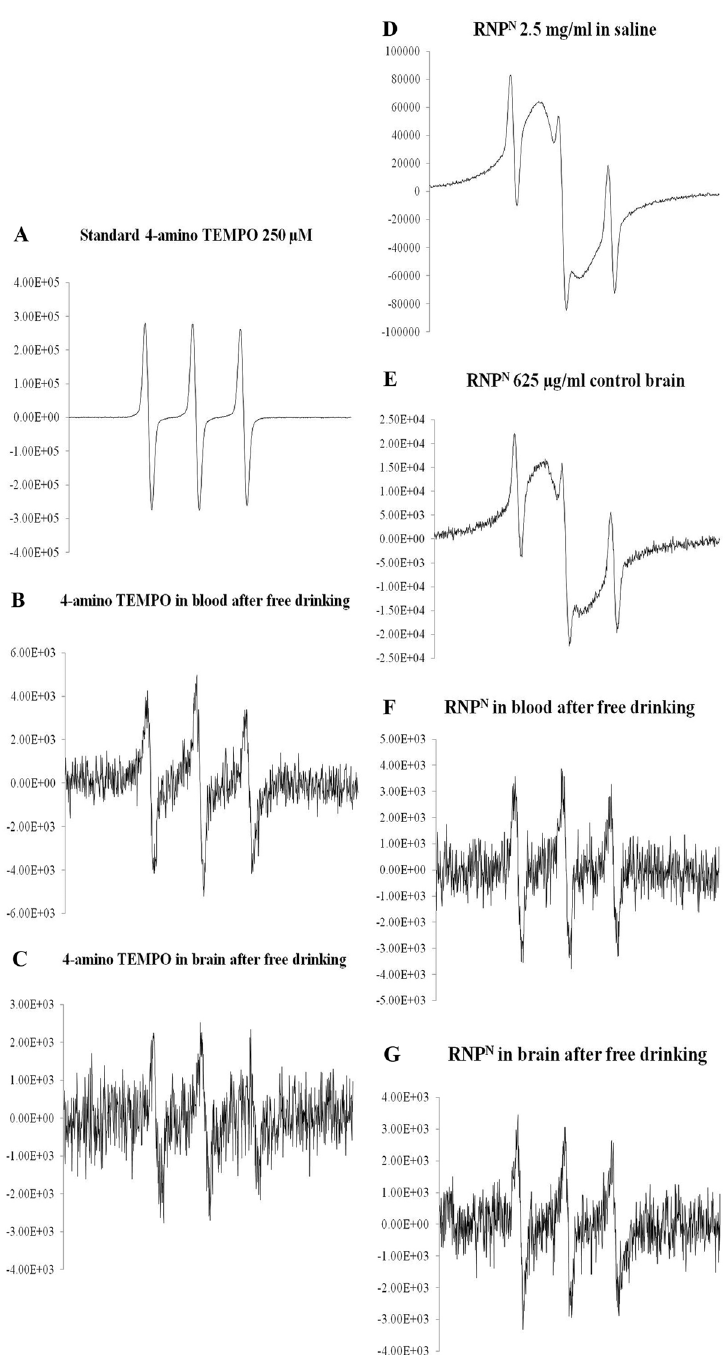
Figure 1. The electron spin resonance (ESR) spectra of 4-amino-TEMPO standard in saline ( A ), 4-amino- TEMPO in the blood after ad libitum drinking for 6 months ( B ) 4-amino-TEMPO in the brain after ad libitum drinking for 6 months ( C ) ESR spectra of RNP N in saline ( D ), RNP N in control brain ( E ), RNP N in the blood after ad libitum drinking for 6 months ( F ), and RNP N in brain after ad libitum drinking for 6 months ( G